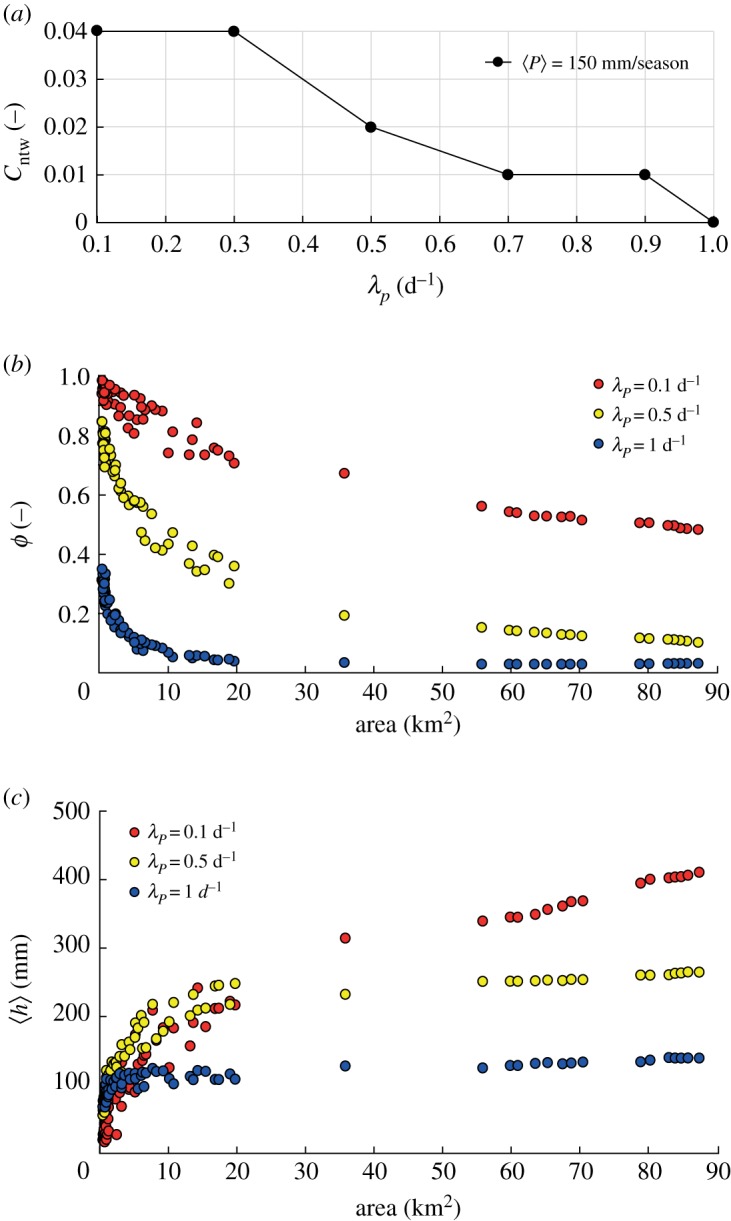
(a) Pattern of network connectivity for increasing rainfall frequency; (b) scaling relation of the runoff coefficient ϕ and (c) scaling relation of the mean stage 〈h〉. All simulations refer to a dry climatic setting (〈P〉 = 150 mm/season and uniform 〈PET〉 = 3.5 mm d−1).